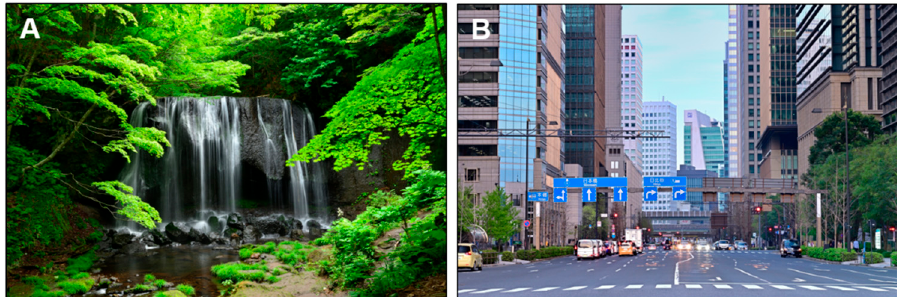
Figure 2. Images used in the visual stimulation. ( A ) Waterfall image: Tatsusawa Fudo Falls, Fuku- shima. ( B ) Urban image: Eitai Street in Otemachi, Tokyo. Fukushima. ( B ) Urban image: Eitai Street in Otemachi,